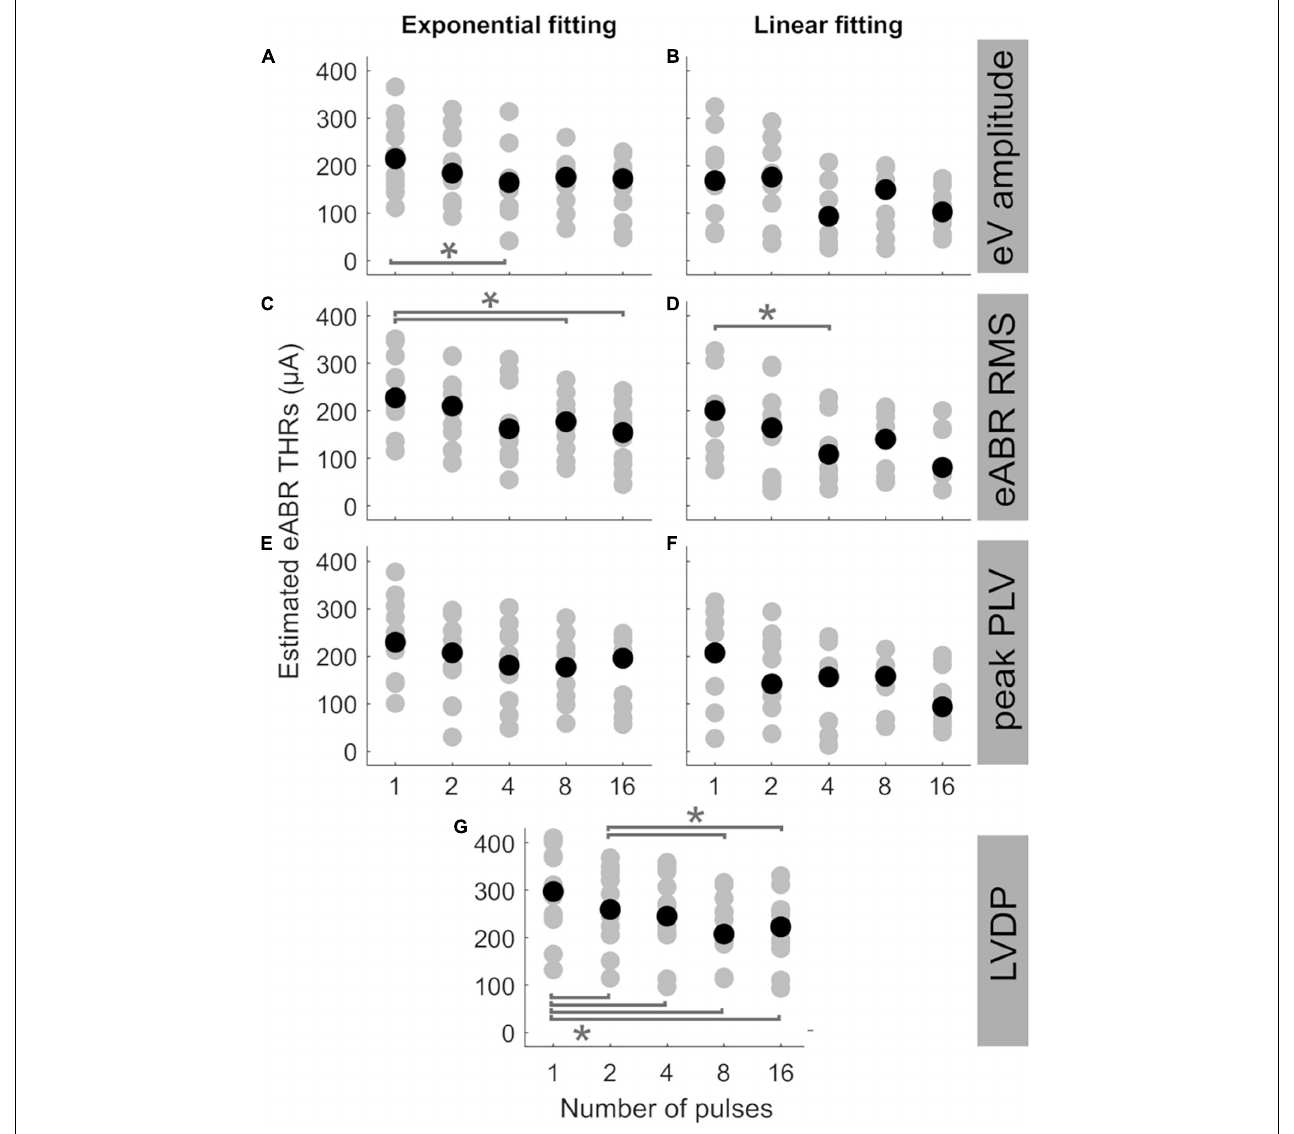
FIGURE 5 | Estimated eABR THRs as a function of number of pulses, resulted from extrapolation of wave eV (A,B) , eABR RMS value (C,D) , peak PLV (E,F) , and LVDP (G) growth functions. For each estimation method, an exponential function (left-side panels) and a linear function (right-side panels) were used for fitting. For the LVDP method, no estimation function was used. Data in gray shows results of individual subjects and data in black shows the corresponding median values across subjects. Asterisks show significant differences with α = 0.95.